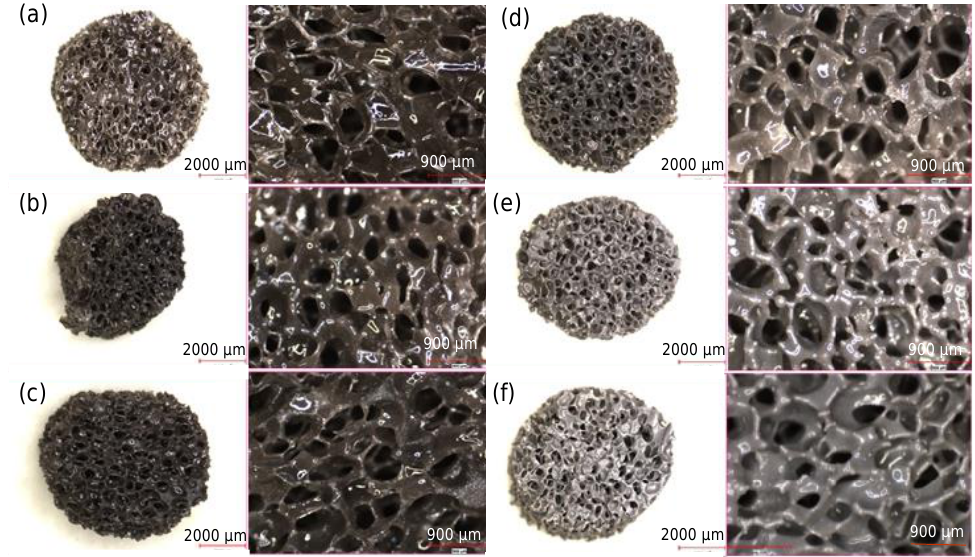
Figure 2. Optical microscope images of the ( a ) bare B3, ( b ) 0.1 hBN, ( c ) 0.2 hBN, ( d ) 0.5 hBN, ( e ) 1 hBN, and ( f ) 2 hBN-containing borate bioactive glass scaffolds. Low magnification image scale bar: 2000 µm; high magnification image scale bar: 900 µm.